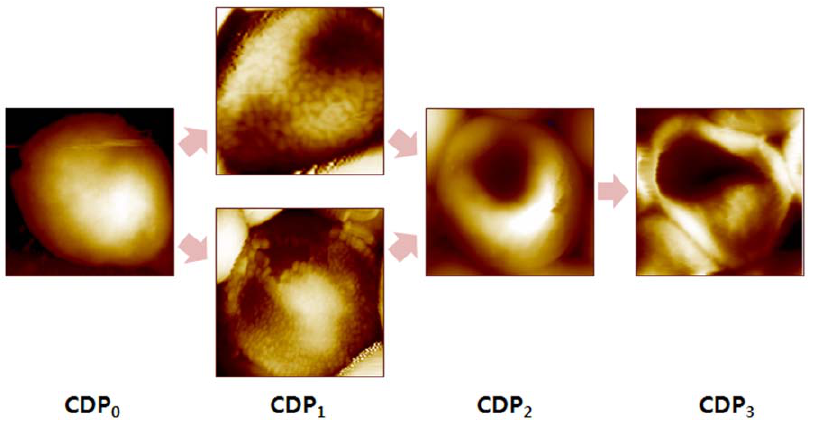
Figure 5. Cell death phase (CDP) of C.albicans induced by flucytosine and amphotericin B. The cell death process can be divided by four phase according to the changes in shape and morphological properties.